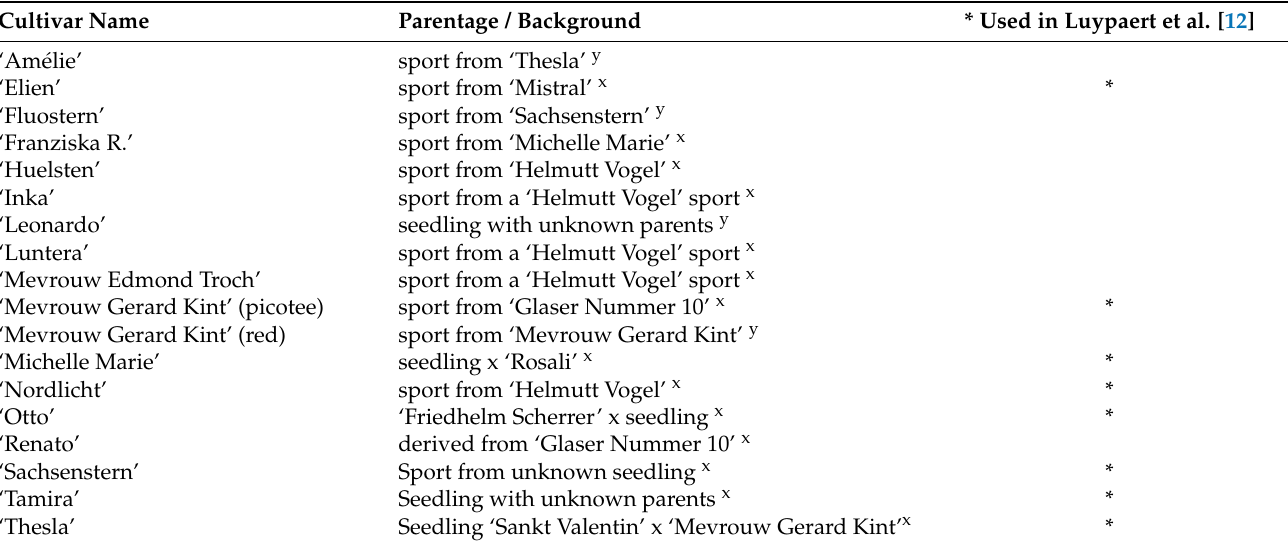
Table 1. Rhododendron simsii hybrids used in the different experiments; cultivars marked with * are also used in Luypaert et al.